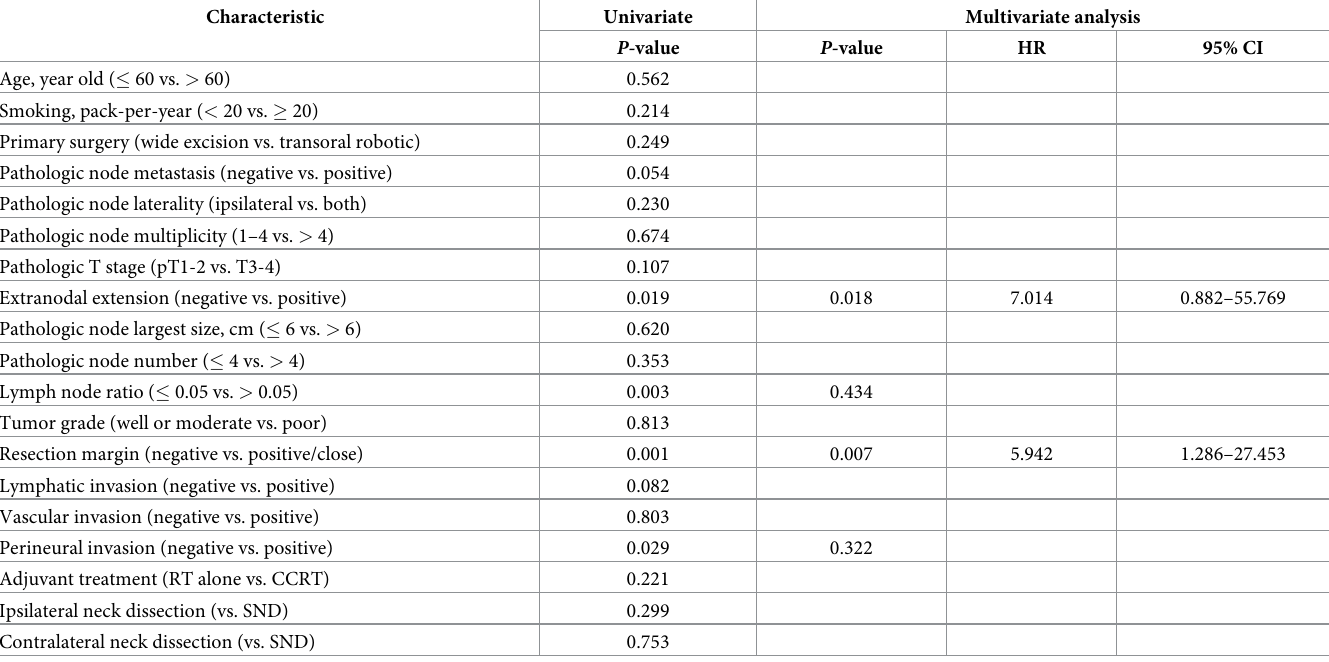
Table 2. Cox-regression analysis predicting survival in HPV-related